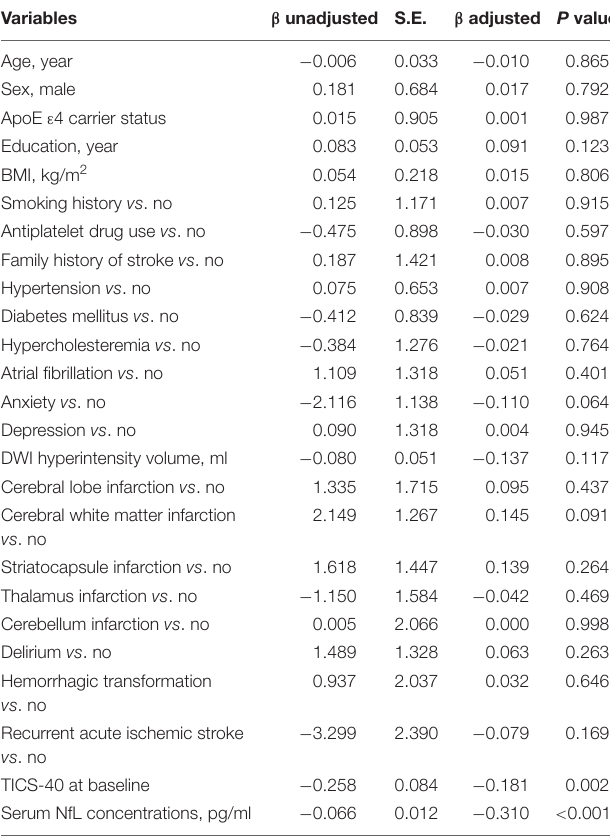
TABLE 3 | A linear regression model to evaluate the risk factors for cognitive impairment as indicated by TICS-40 scores at endpoint in patients with subjective cognitive impairment post-stroke.